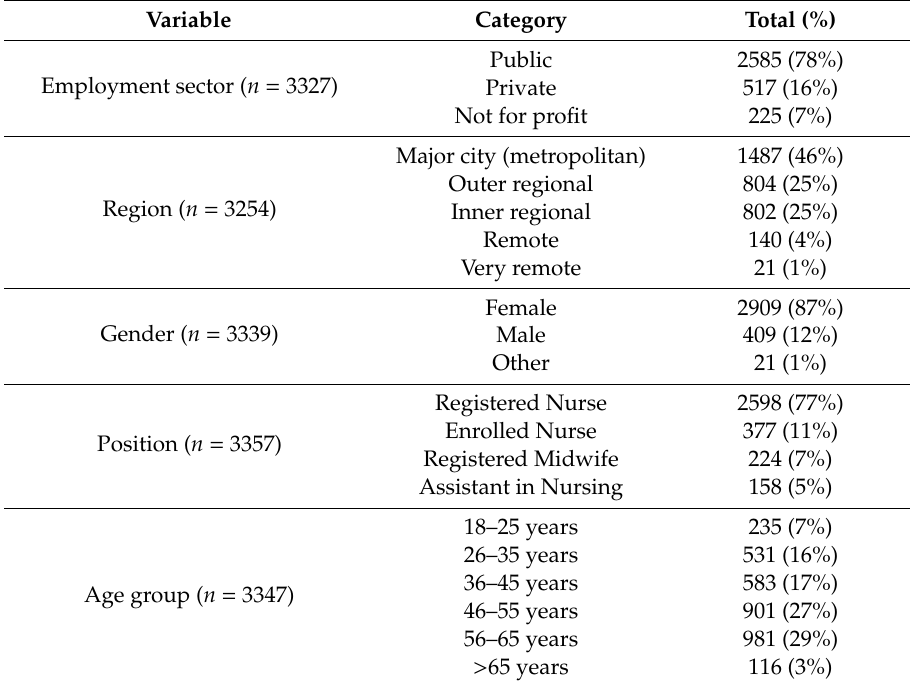
Table 1. Participant